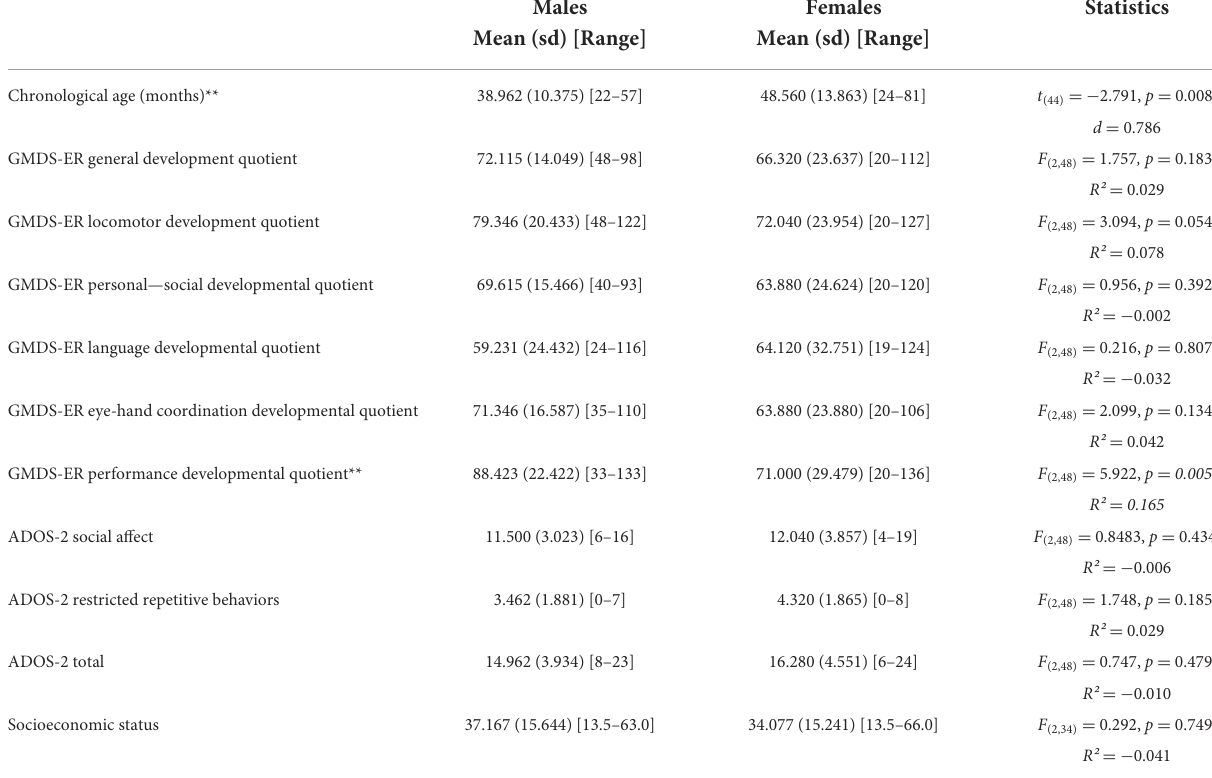
TABLE 2 Demographic and clinical measures